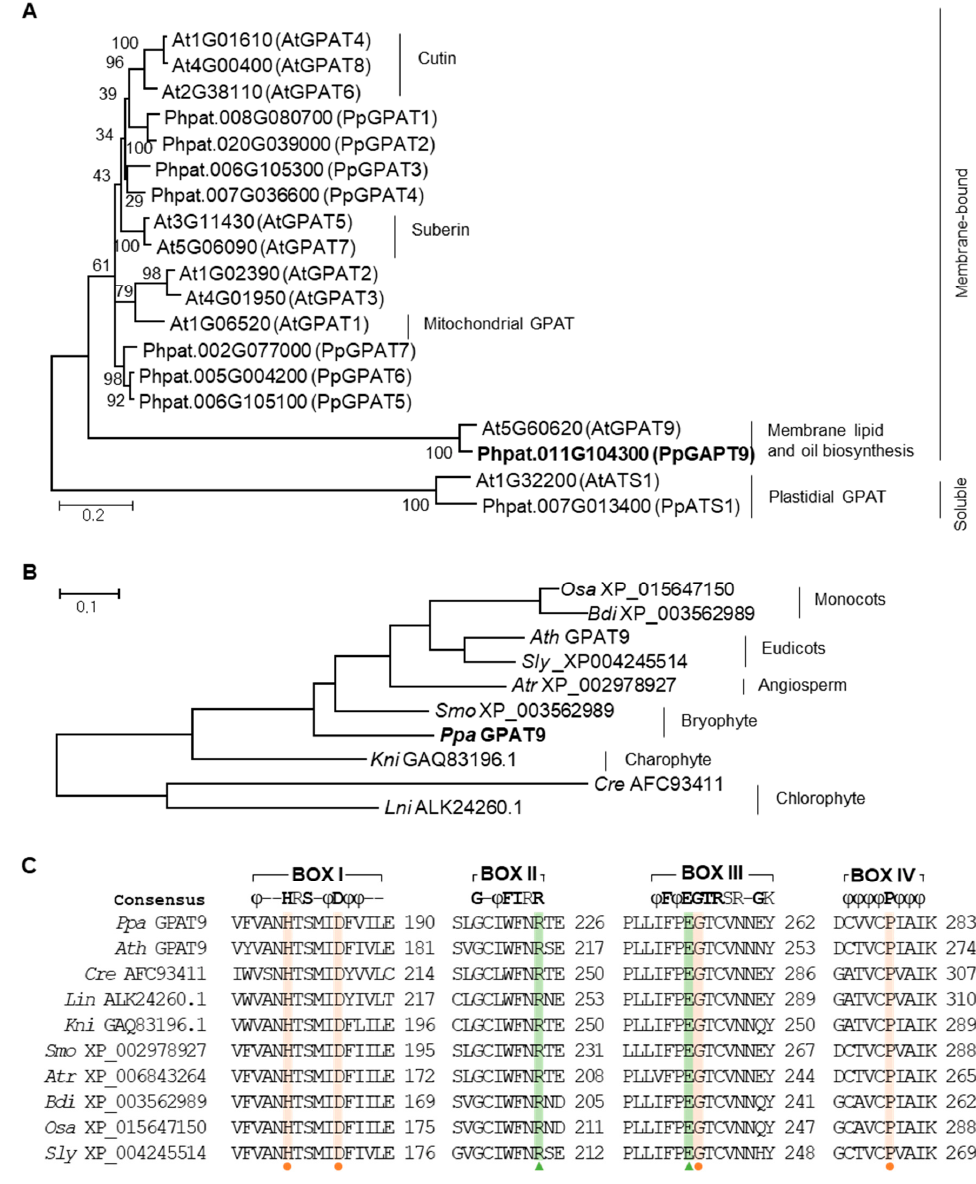
Figure 1. Phylogenetic trees for PpGPATs and AtGPATs ( A ) and PpGPAT9 and GPAT9s from other organisms ( B ), and conserved acyltransferase motifs ( C ) of GPAT9s. ( A ) The phylogenetic trees were constructed using the MEGA6 program and amino acid sequences of A. thaliana and P. patens GPATs obtained from the Phytozome v11.0 database (https://phytozome.jgi.doe.gov/) by using BLAST with a cutoff e-value of 1 × 10 − 5 . ( B ) Homologs of PpGPAT9 were isolated from the genome database by using BLAST with a cutoff e-value of 1e-5 in Phytozome v12.1 (https://www.phytozome.net), NCBI (https://ncbi.nlm.nih.gov/), and UniProt (http://www.uniprot.org). Phylogenetic analysis was conducted using the Maximum Likelihood method in MEGA6 with multiple amino acid sequences. PpGPAT9 indicated in bold was used in this study. ( C ) Amino acid sequence alignment of GPAT9 isoforms from P. patens and other organisms by using CLUSTALW. Four conserved acyltransferase motifs (BOX I–IV) are shown in colored boxes, according to Lewin et al. [44]. The amino acid residues indicated using orange circles in BOX I, BOX III, and BOX IV are required for GPAT catalysis. Hydrophobic amino acids are represented by “ φ .” The following amino acids are